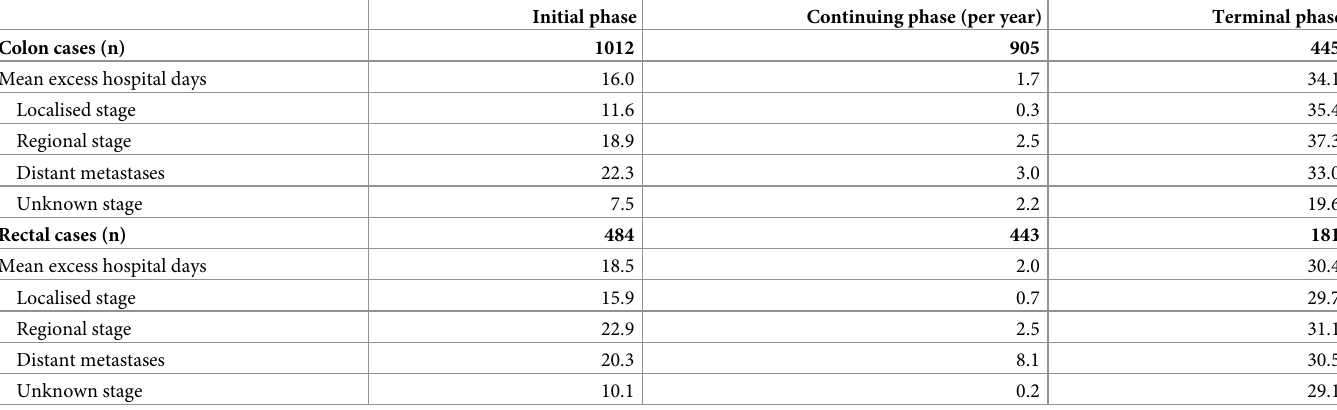
Table 3. Mean excess hospital days for colon and rectal cases diagnosed 2006–2013 in the 45 and Up Study, by phase of care and disease